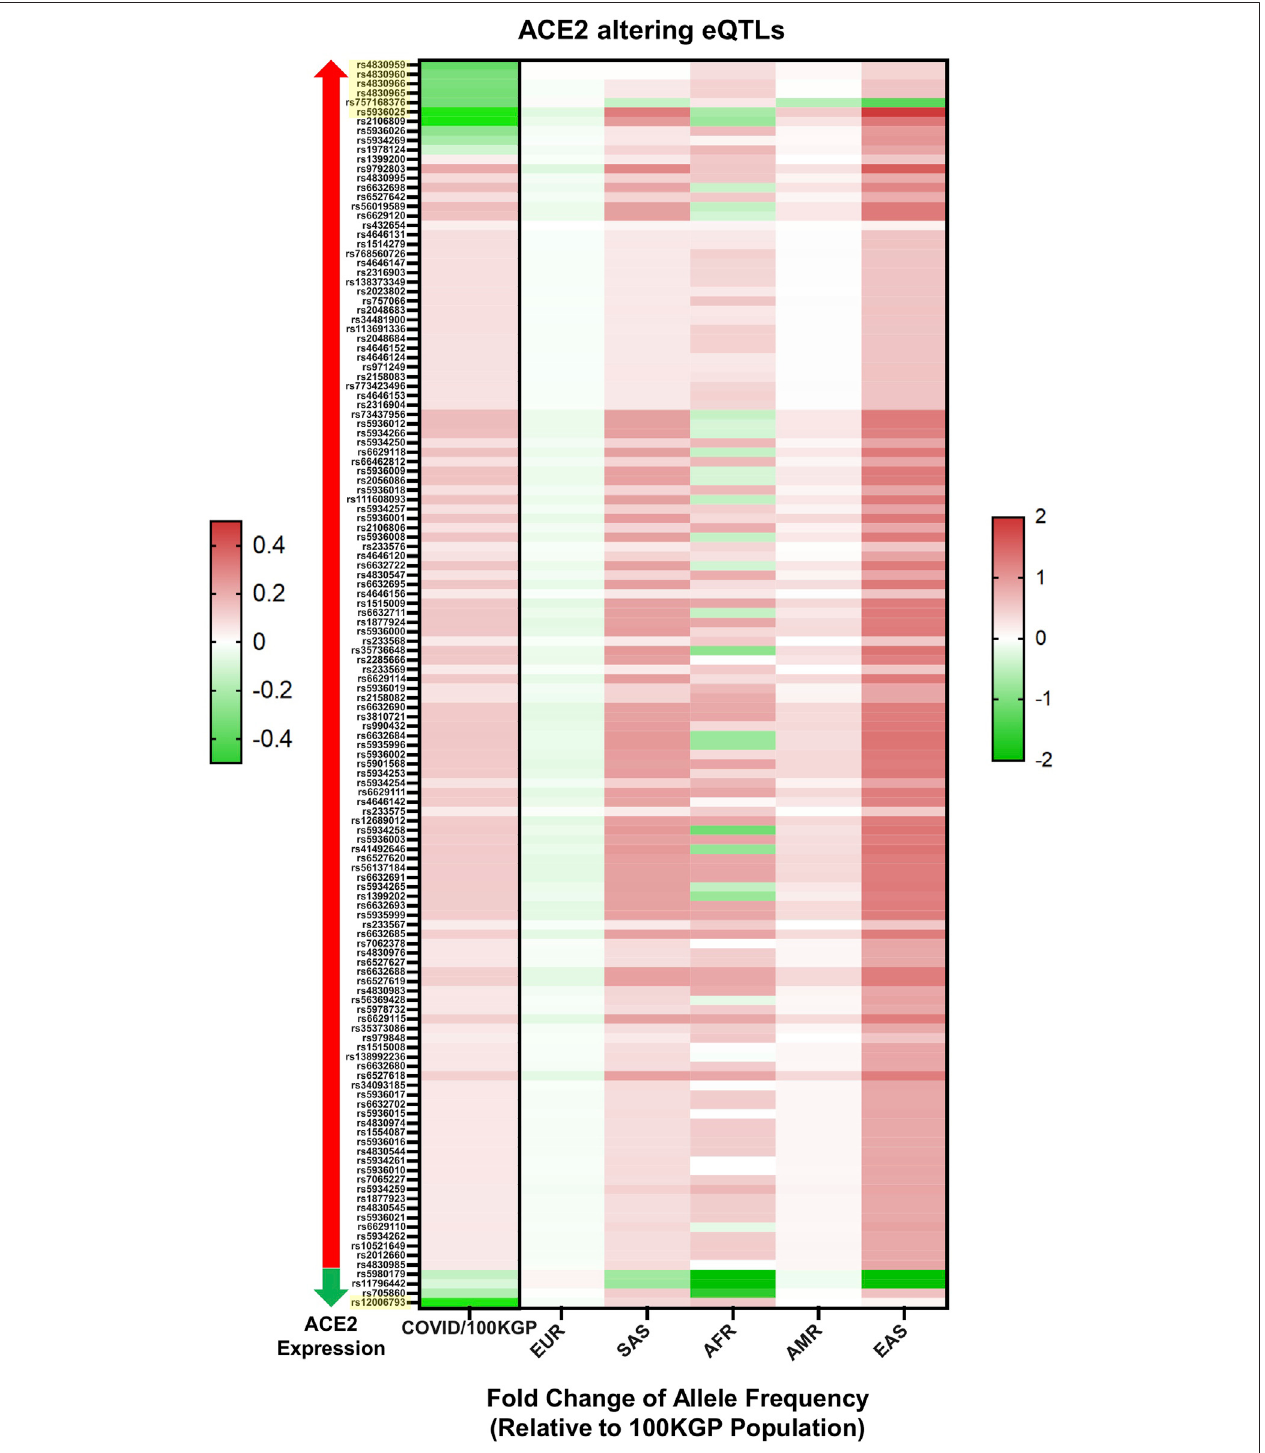
FIGURE 4 | Statistically signi fi cant eQTLs in SARS-CoV-2 positive individuals. Displayed by total positive individuals (value on the left) and by ethnic background (value on the right), values are presented as log base 2-fold change relative to the allelic frequency within non-positive individuals found in the 100KGP (n = 37,207). eQTLsarealsosubdividedbyeffectsonACE2expression,witheQTLsknowntoassociatewithincreasedACE2expressionmarkedbyaredarrowandthoseassociated with decreased ACE2 expression marked by a green arrow. All displayed eQTLs are signi fi cant based on chi-squared test, and yellow highlighted eQTLs had Cohen ’ s values above 0.2. All eQTLs are referenced by rs identi fi ers.